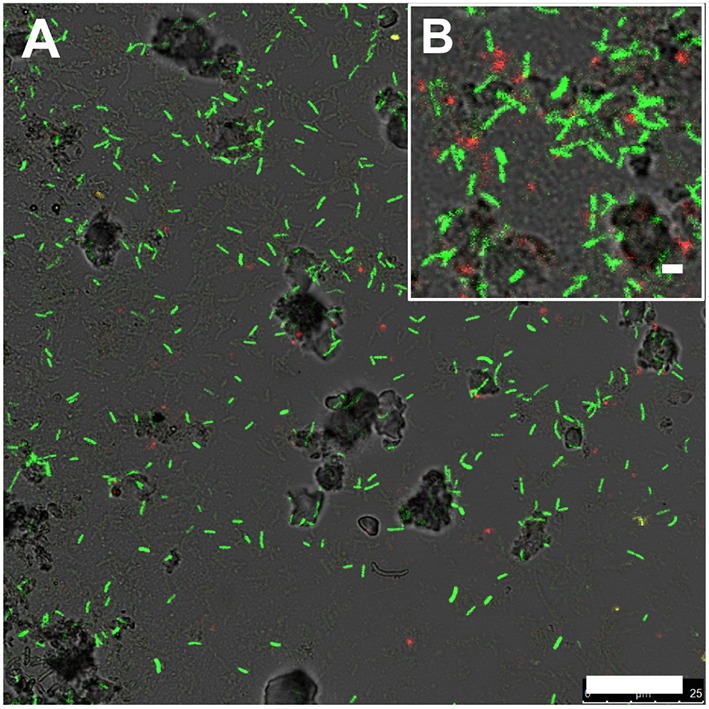
Fluorescence in situ hybridization image of slides incubated in Beowulf Spring for 6 days (A,B). Green rods are Hydrogenobaculum spp. (6FAM-Aqi338) and red cocci are archaea (Cy5-Arch915). Scale bar = 20 μm (A) and 1 μm (B).